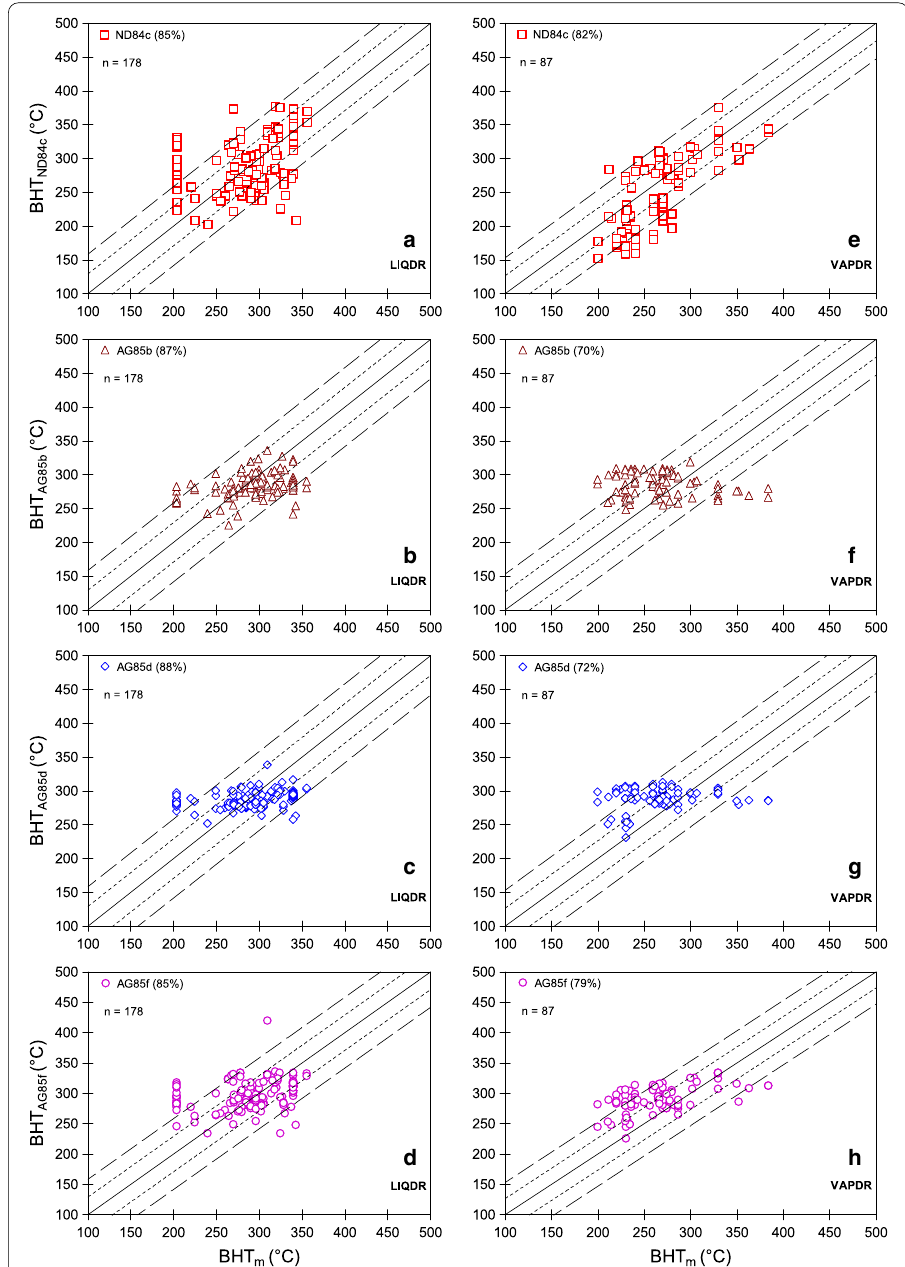
Fig. 6 Results of a comparative analysis between measured (BHT m ) and temperature estimates calculated by four existing gas geothermometers (BHT GasGeo_Lit ). The plots a – d show results of the ND84c, AG85b, Ag85d, and AG85f geothermometers obtained for LIQDR wells, whereas the plots e – h represent the results of the same geothermometers for VAPDR wells. Dotted and dashed lines represent a hypothetical variability of the 10% and 20% with respect to the BHT mean value, ± ±